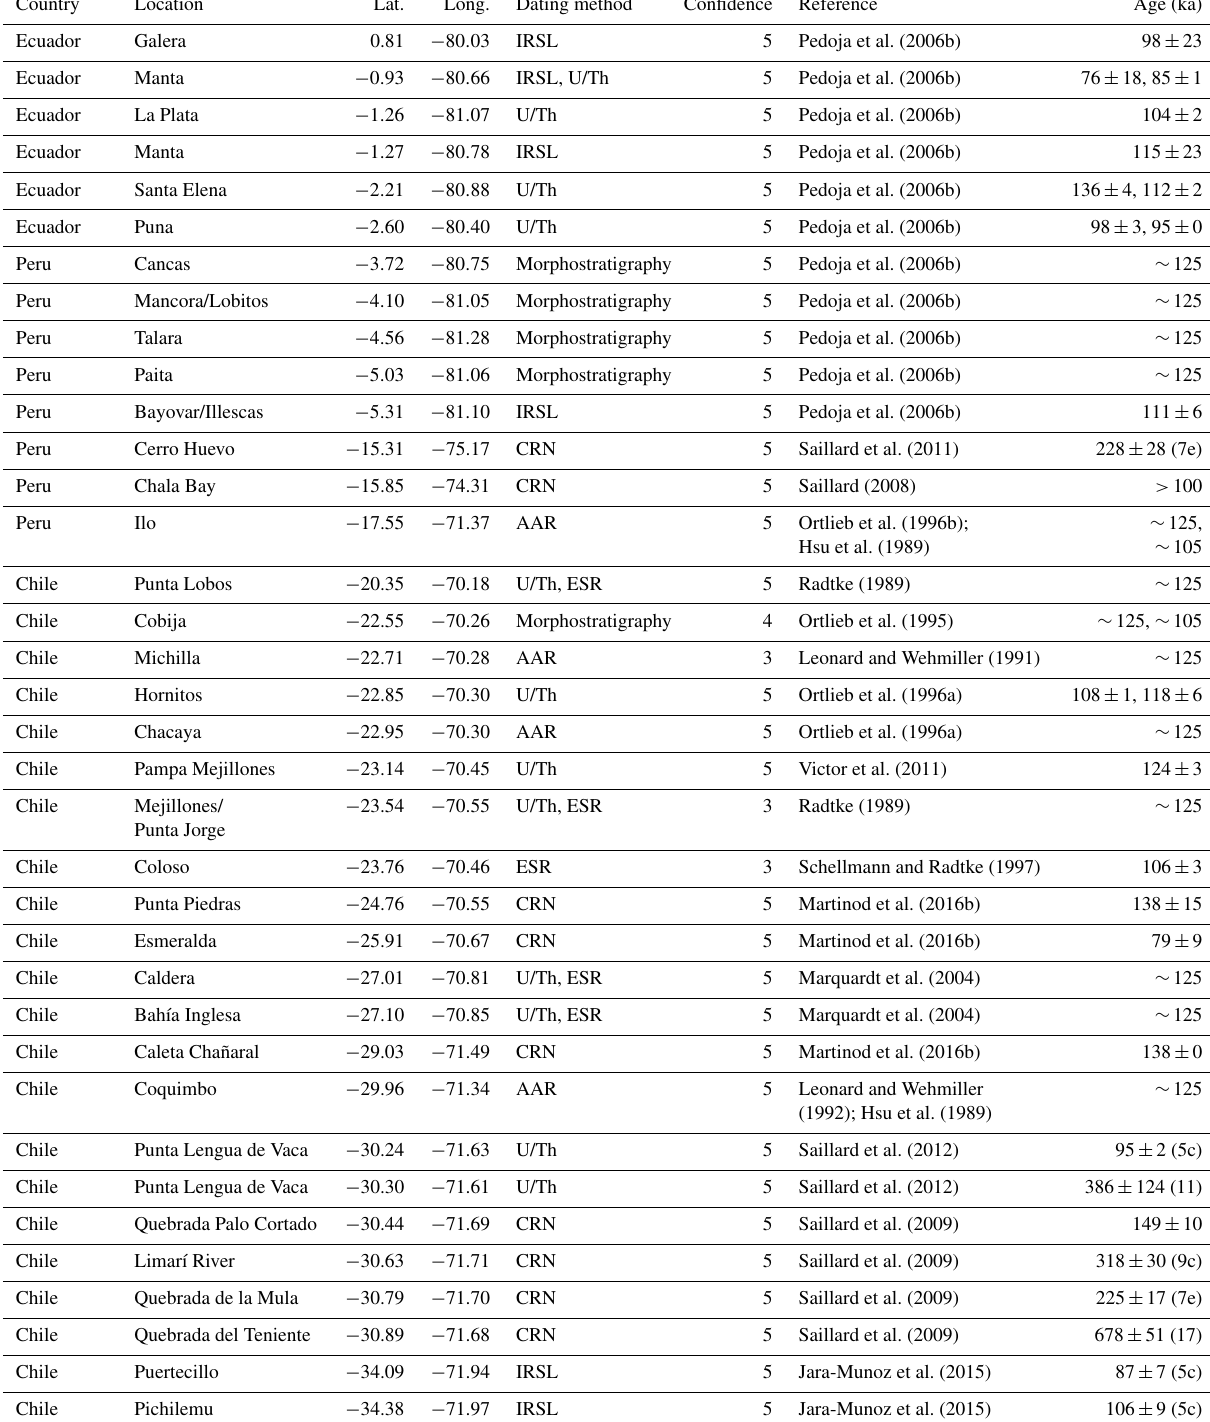
Table 1. Age constraints used for mapping of the inner edge of MIS 5 and for verifying our terrace-elevation measurements. This compilation is mainly based on the terrace catalog of Pedoja et al. (2011); added references include Victor et al. (2011) for Pampa de Mejillones, Martinod et al. (2016b) for northern Chile, and Jara-Muñoz et al. (2015) for south-central Chile. Absolute ages refer to MIS 5e marine terraces unless otherwise specified; inferred ages refer to their associated MIS. IRSL: infrared-stimulated luminescence, AAR: amino-acid racemization, CRN: cosmogenic radionuclides, ESR: electron spin